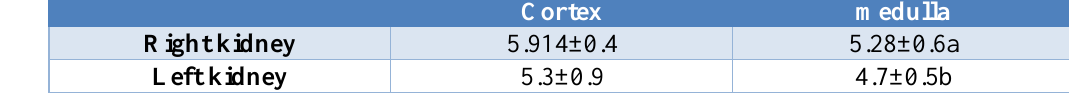
Table, 2: Thickness (mm) of cortex and medulla of the right and left kidneys of male guinea pig.